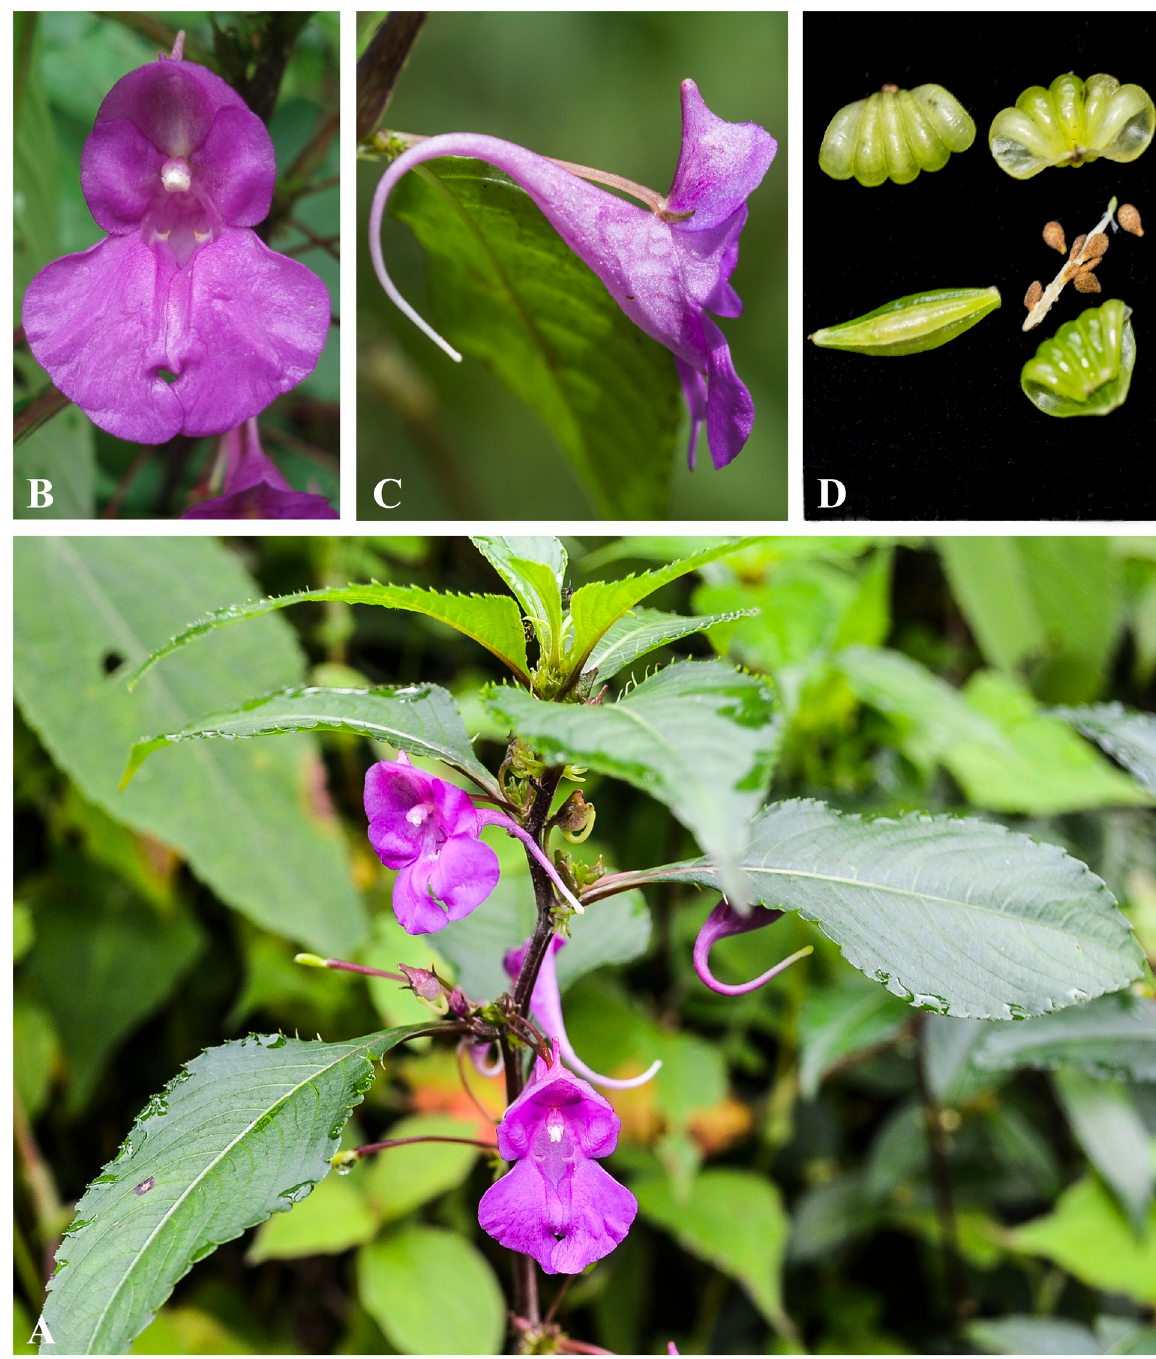
Fig 16. Impatiens infundibularis A. Flowering plant; B. Flower (front view); C. Flower (side view); D. Capsule and seeds. Photographs by Bhakta Bahadur Raskoti.